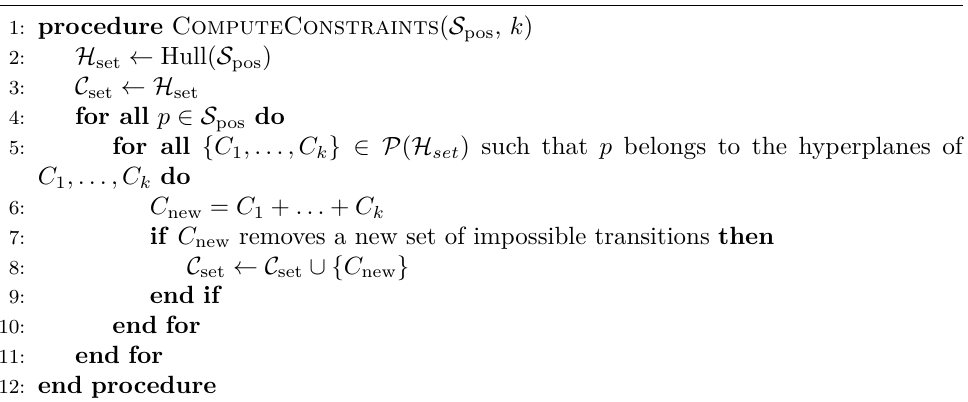
Algorithm 1 Compute a set of inequalities from possible transitions.